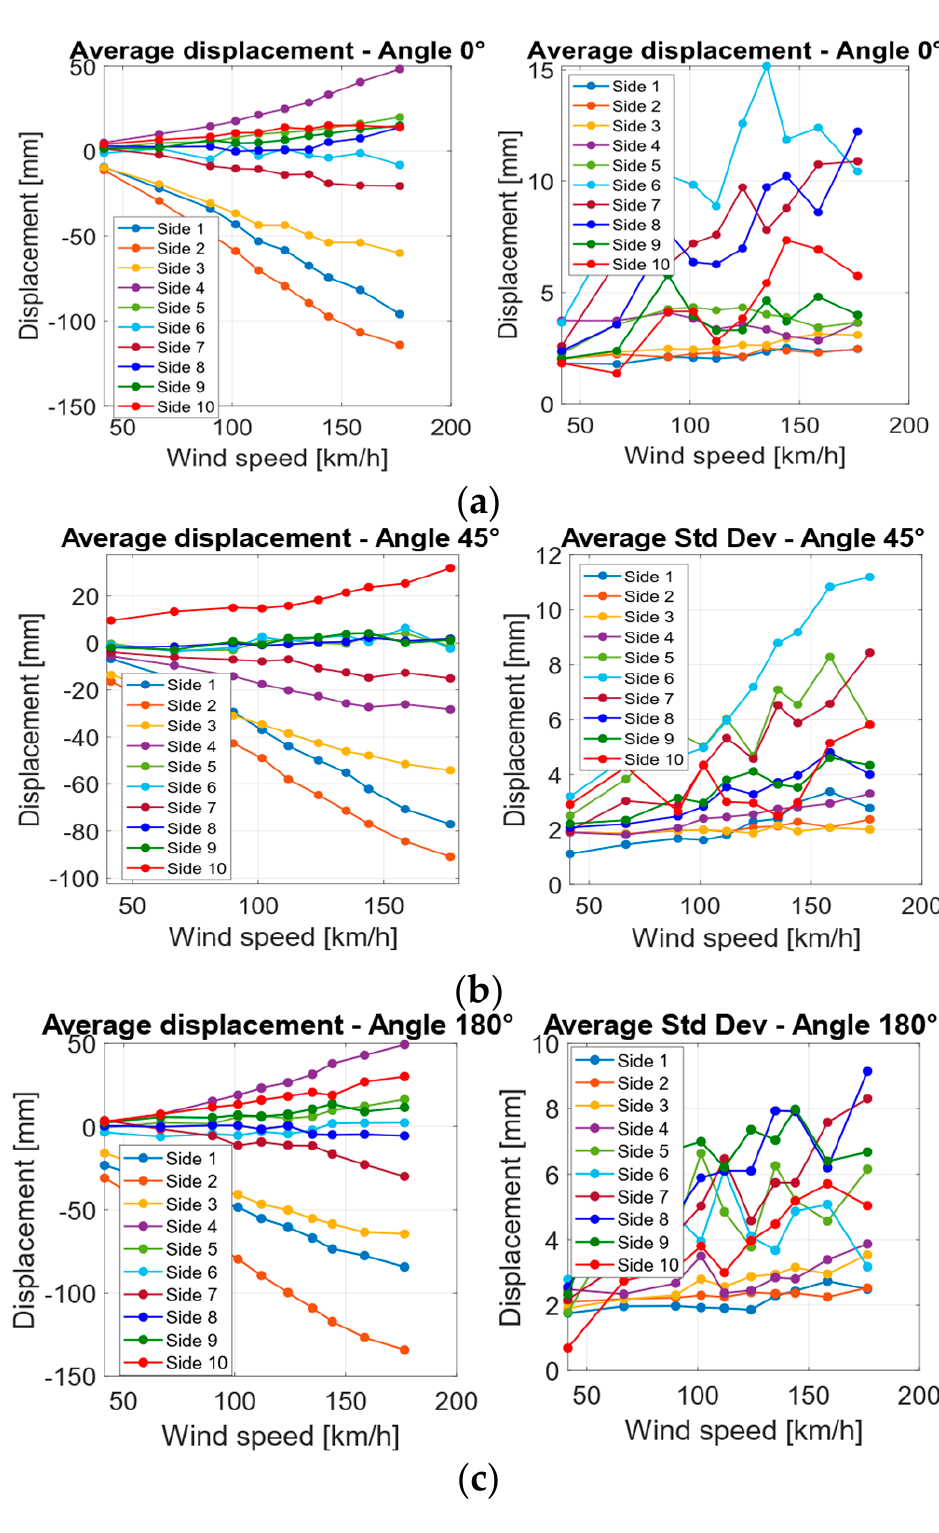
Figure 13. Average displacements and standard deviation for each side of the decagonal base structure at 1/2 of the total height for different wind velocities for angles 0° ( a ), 45° ( b ), 180° ( c ).